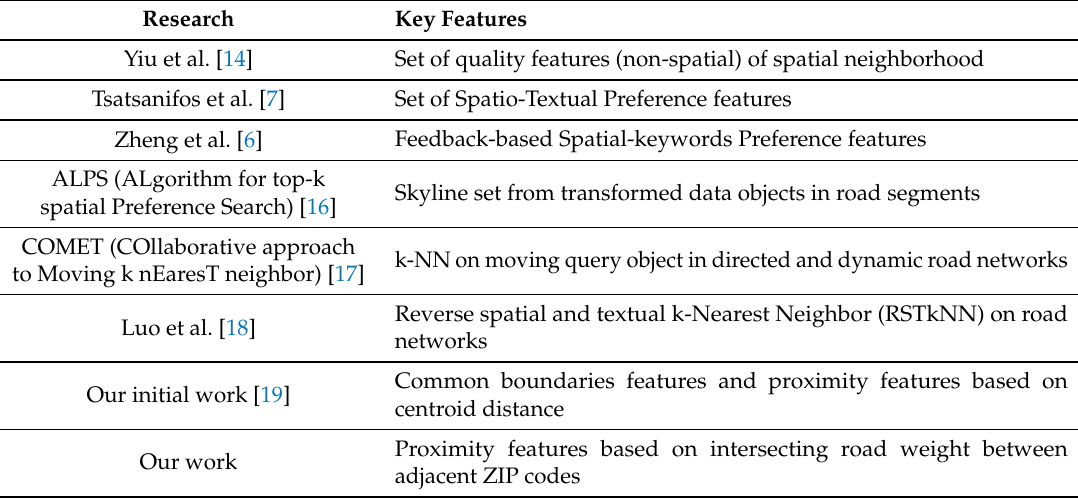
Table 2. Research on top-k spatial queries.